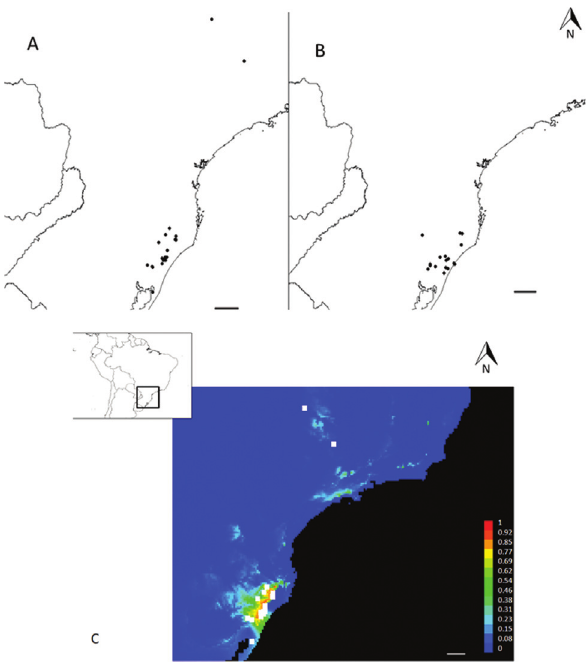
Figure 6 - Map of the distribution of Calydorea crocoides (A); conserva- tion areas (B), and potential geographical distribution for Calydorea crocoides according to maximum entropy (C). Similarity values the low- est training threshold are shown from light blue to red, values below this threshold are present in dark blue. Black circles indicate the accessions of Calydorea crocoides (A) and conservations areas (B). White squares indi- cate the accessions of Calydorea crocoides (C). Scale = 100